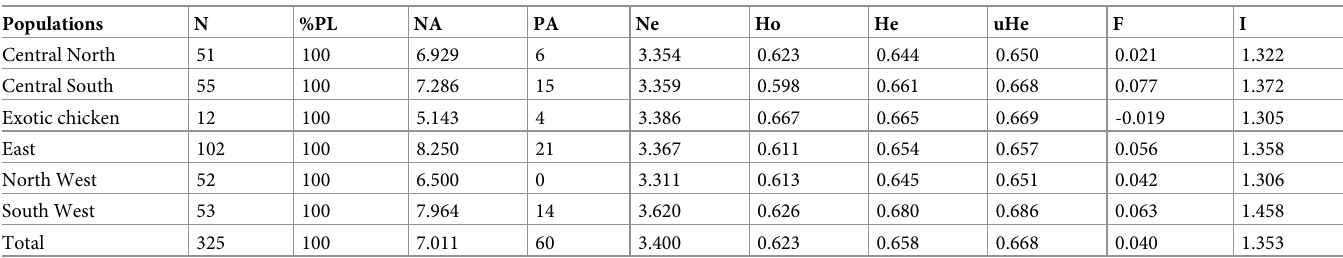
Table 3. Common genetic diversity indices as revealed among IC populations in Rwanda. Populations